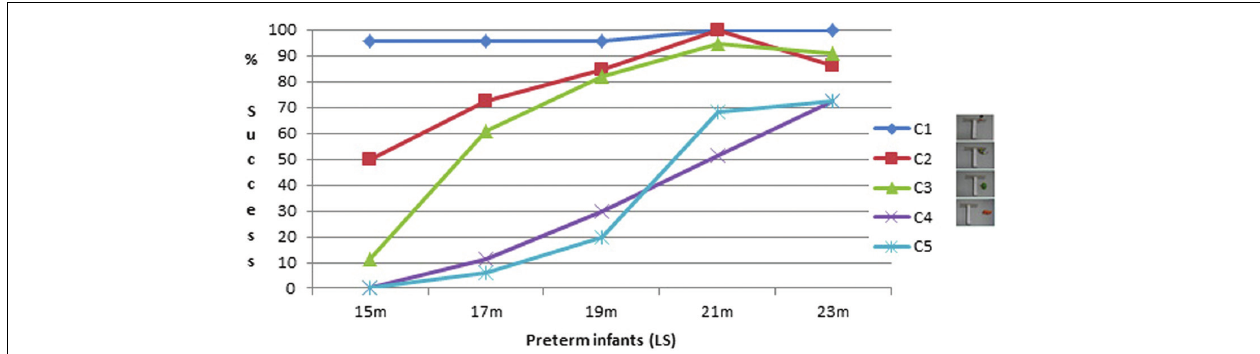
FIGURE 2 | Percentage of successful infants (Preterm